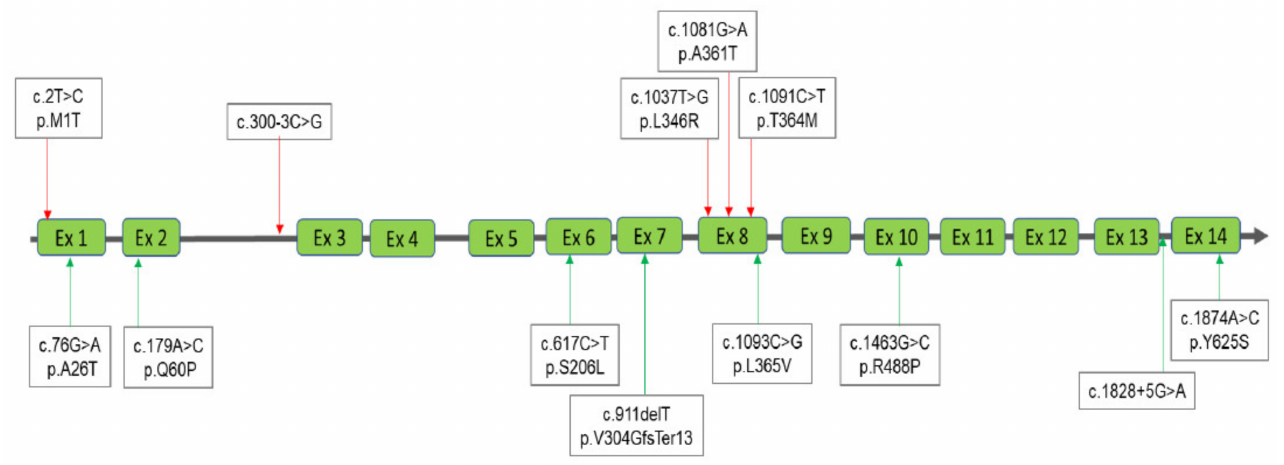
Figure 2. A total of 13 mutations of the IDUA gene underlying Taiwanese Hurler-Scheie syndrome were found; of those, five had been reported previously (red lines with arrows) and the other eight were novel mutations (green lines with